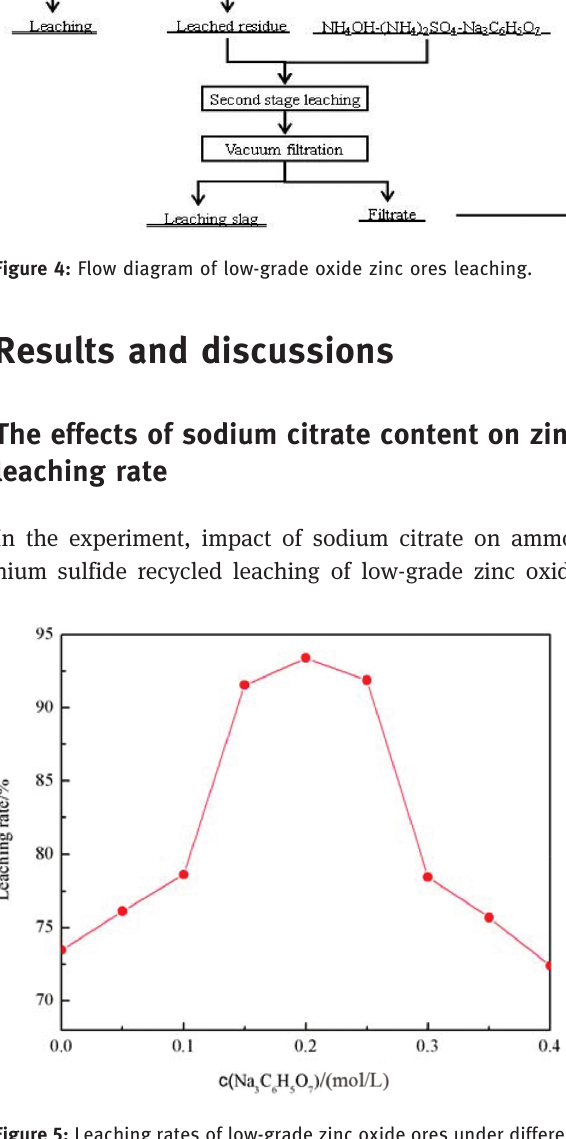
Figure 5: Leaching rates of low-grade zinc oxide ores under different sodium citrate contents.